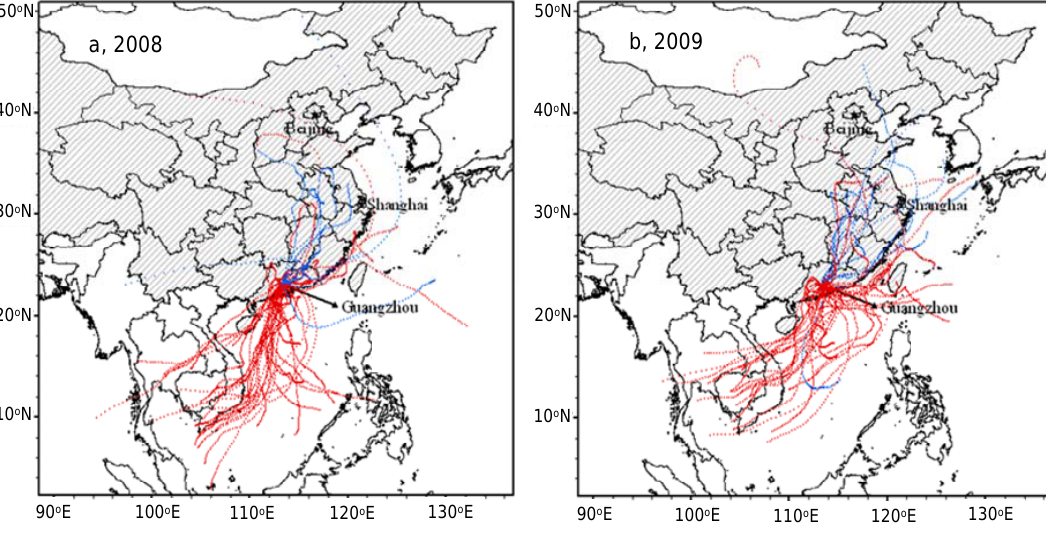
797 Fig. 3. 72-hour air mass backward trajectories for all sampling days in Guangzhou City, based on NOAA HYSPLIT model back trajectories. Lines in blue denote air mass trajectories occurring in the cool season and those in red denote trajectories in the warm